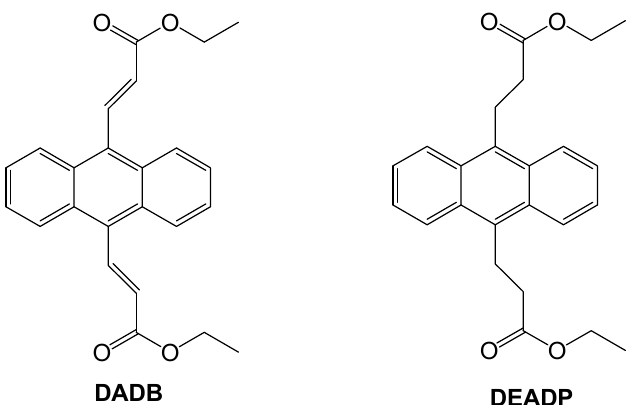
Figure 1. Chemical structure of anthracene derivatives diethyl-(2E,2 ′ E)-3,3 ′ -(anthracene-9,10-diyl)di(prop-2-enoate) (DADB) and diethyl-(2E,2 ′ E)-3,3 ′ -(anthracene-9,10-diyl)di(prop-2-enoate) (DEADP).